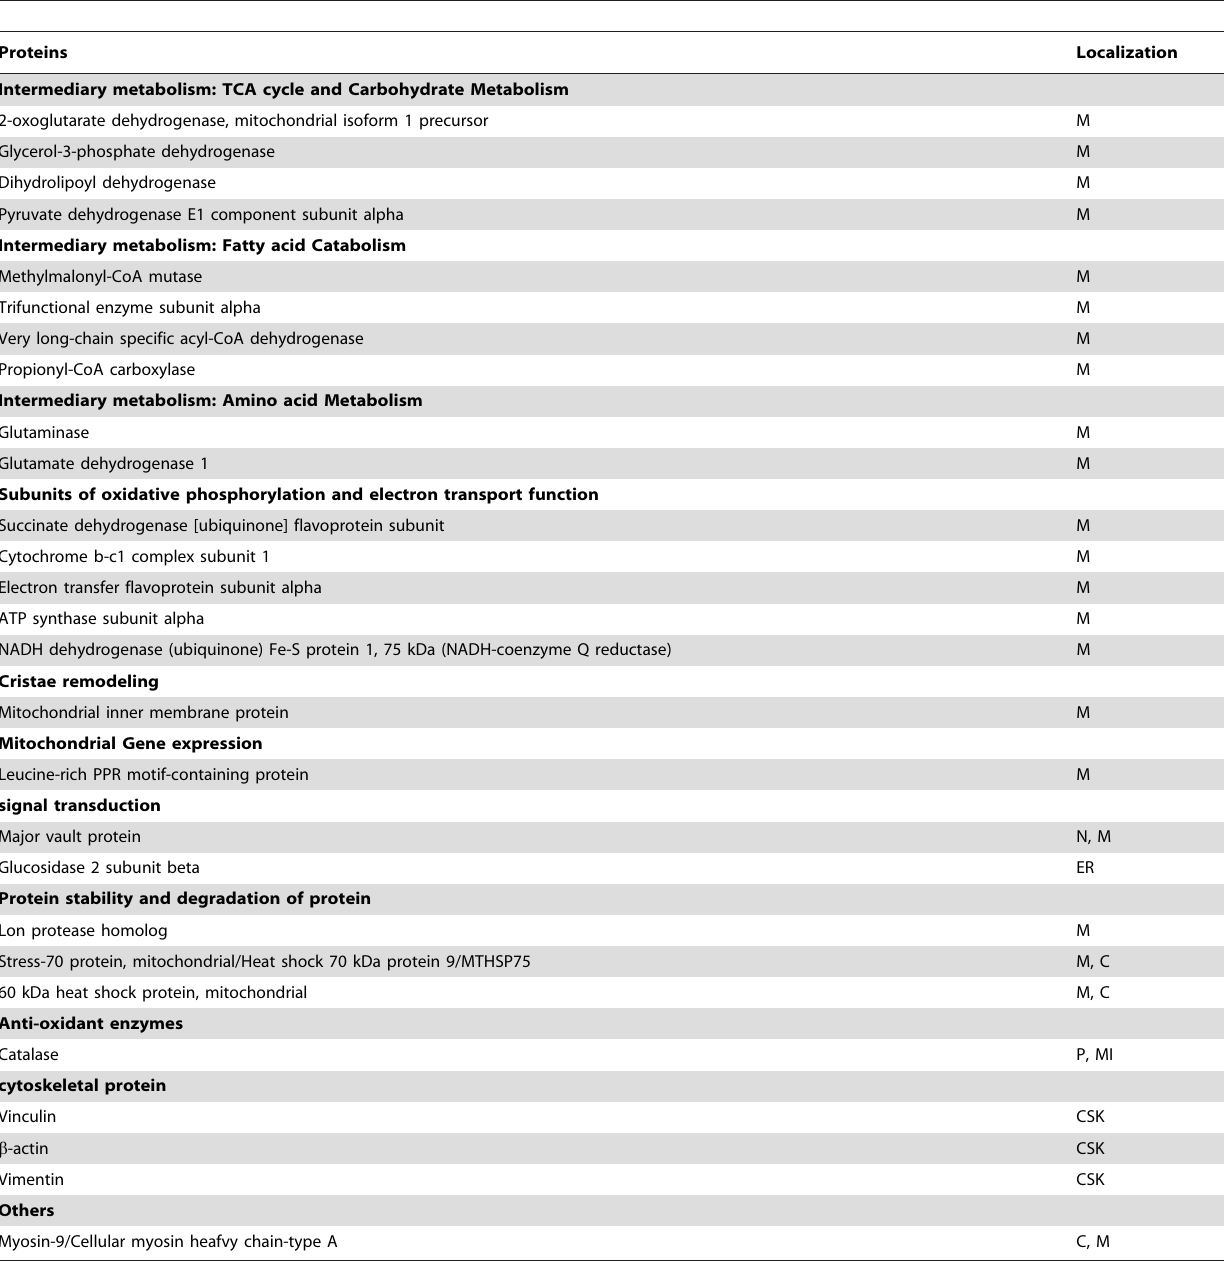
Table 5. Functional categories and sub-cellular localizations of proteins identified in the study based on the MitoMiner Database and